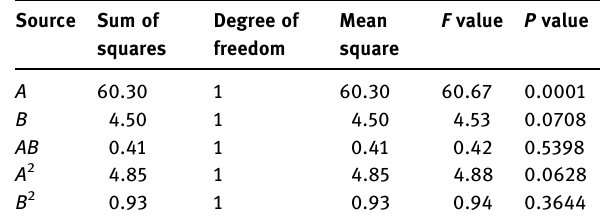
Table 4: Variance analysis of yield Source Sum of squares